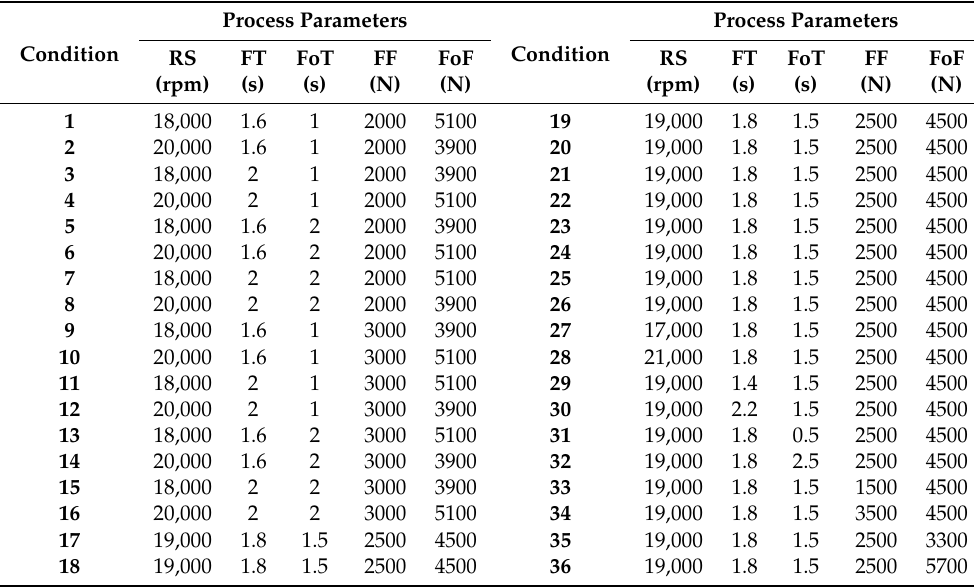
Table 2. Process parameter sets used for this